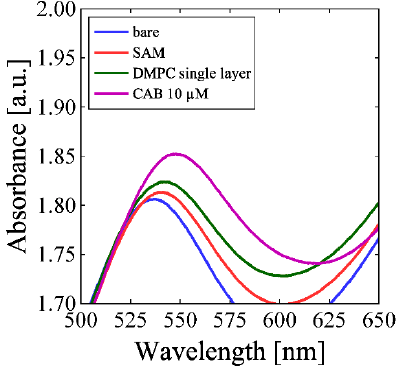
Figure 5. Absorbance for immobilized with DMPC single layer vs LSPR